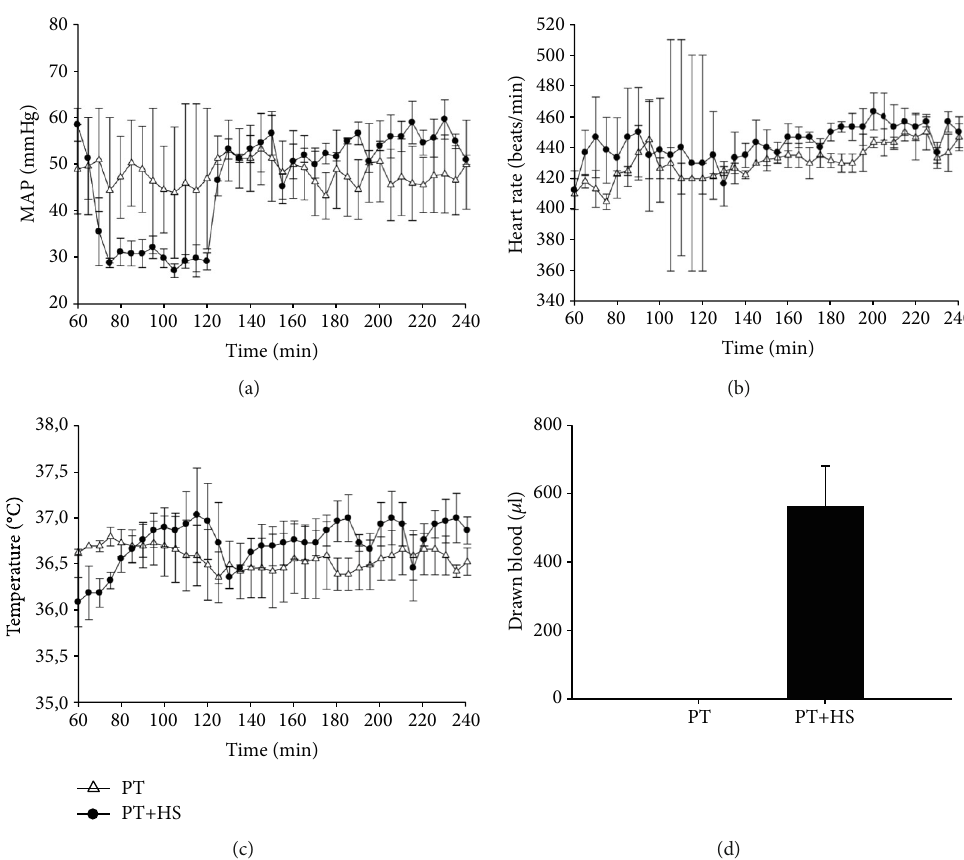
Figure 1: Mean arterial pressure (MAP) (a), heart rate (b), body temperature (c), and volume of blood drawn for the induction of the hemorrhagic shock (d) in mice after polytrauma (PT) and polytrauma with hemorrhagic shock (PT